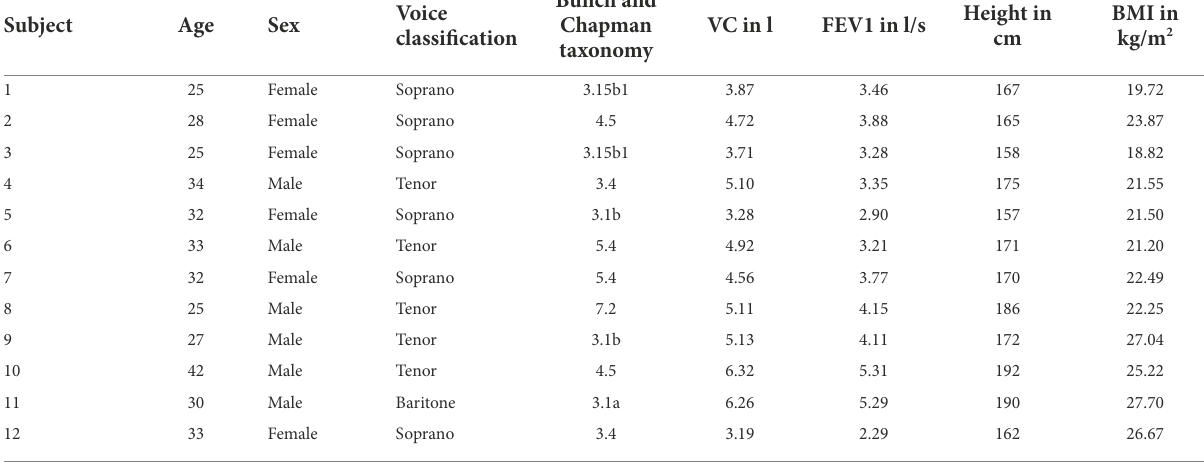
TABLE 1 Subject number, age, sex, voice classification, classification according to the Bunch and Chapman taxonomy (Bunch and Chapman, 2000), vital capacity (=VC), forced expiratory volume in 1 s (= FEV1), body height and body-mass-index